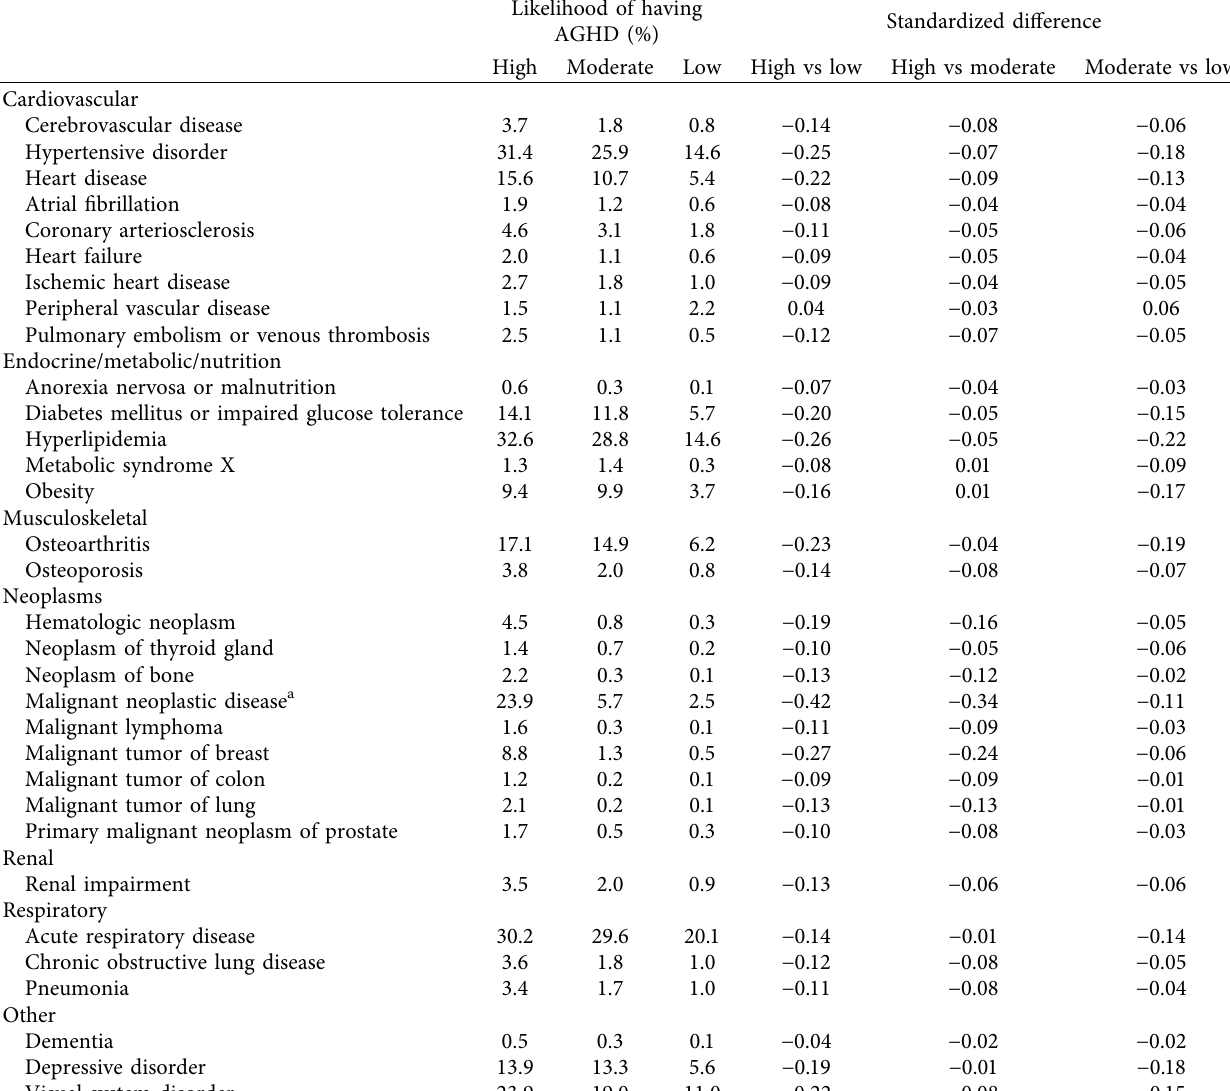
Table 2: Comorbidities of the study cohort by the likelihood of having AGHD.